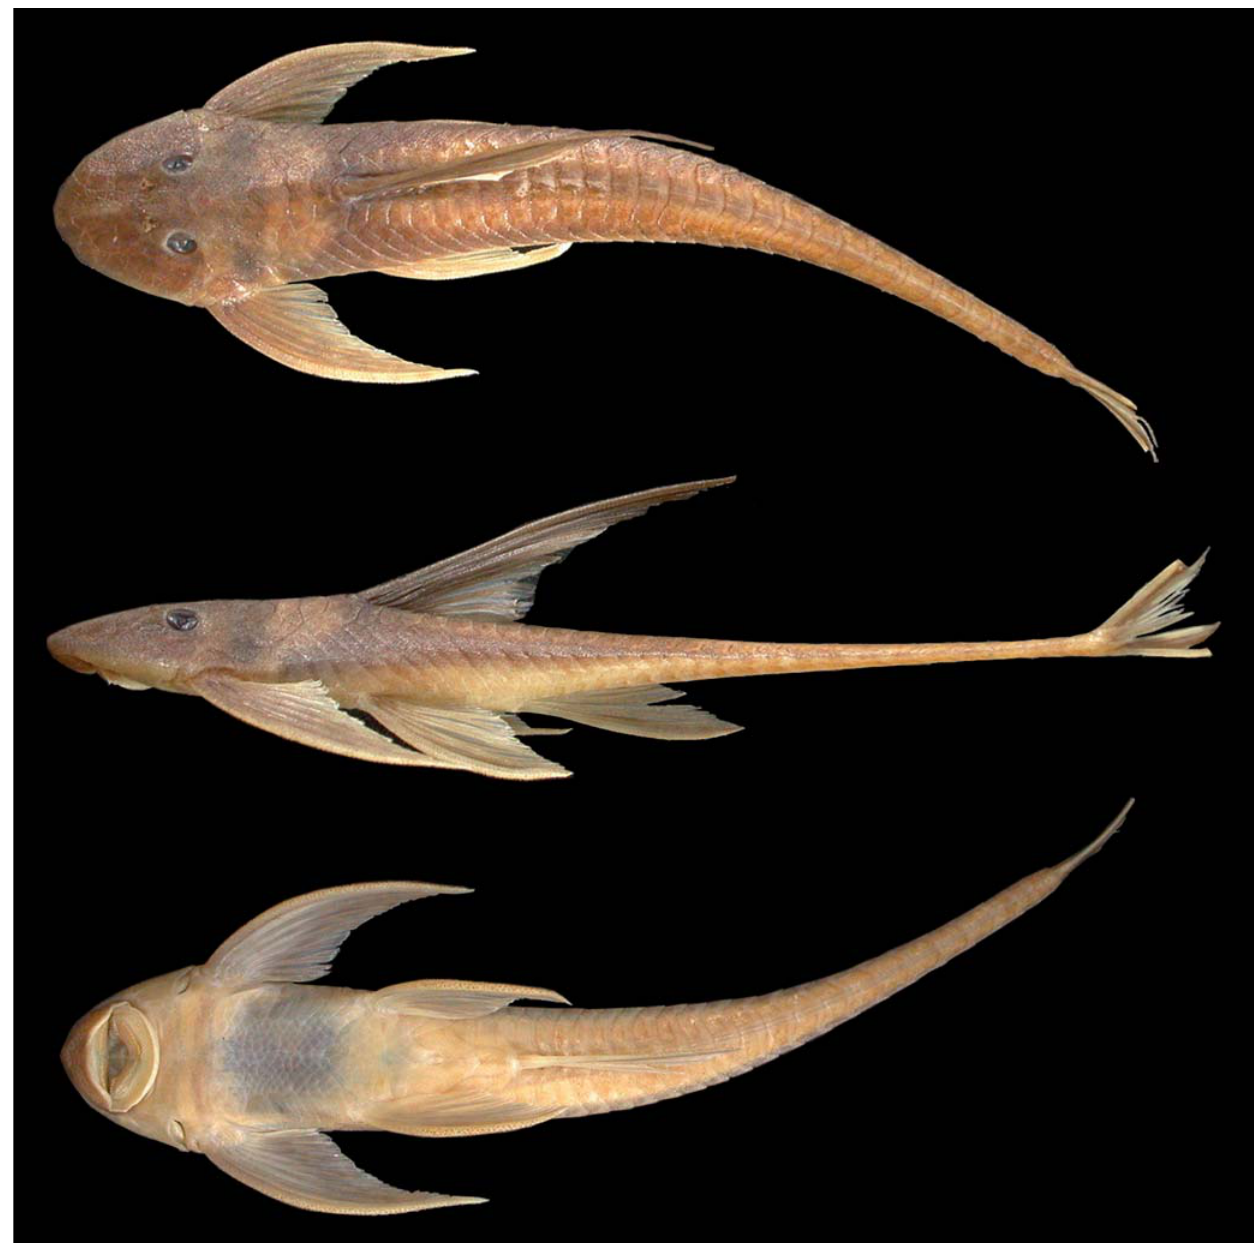
Fig. 14. Lamontichthys stibaros , INHS 84111, 100.1 mm SL. Dorsal, lateral and ventral